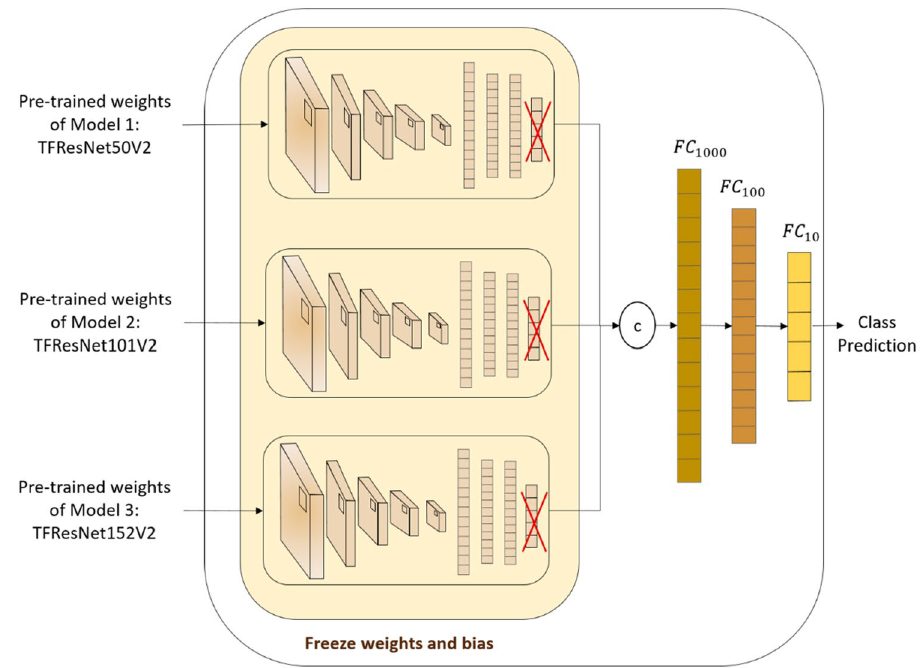
Figure 2. Framework of the classification Stacked Ensemble of ResNet models.